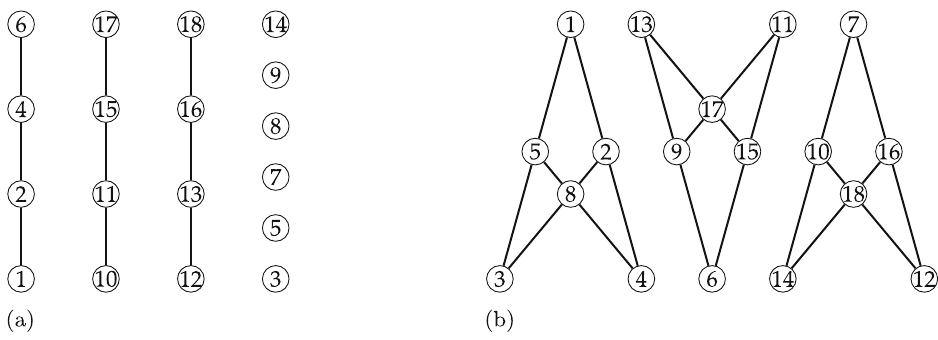
Figure 19: Two geometric representations of triangular matroids induced by ( a ) L 18 and ( b ) P 18